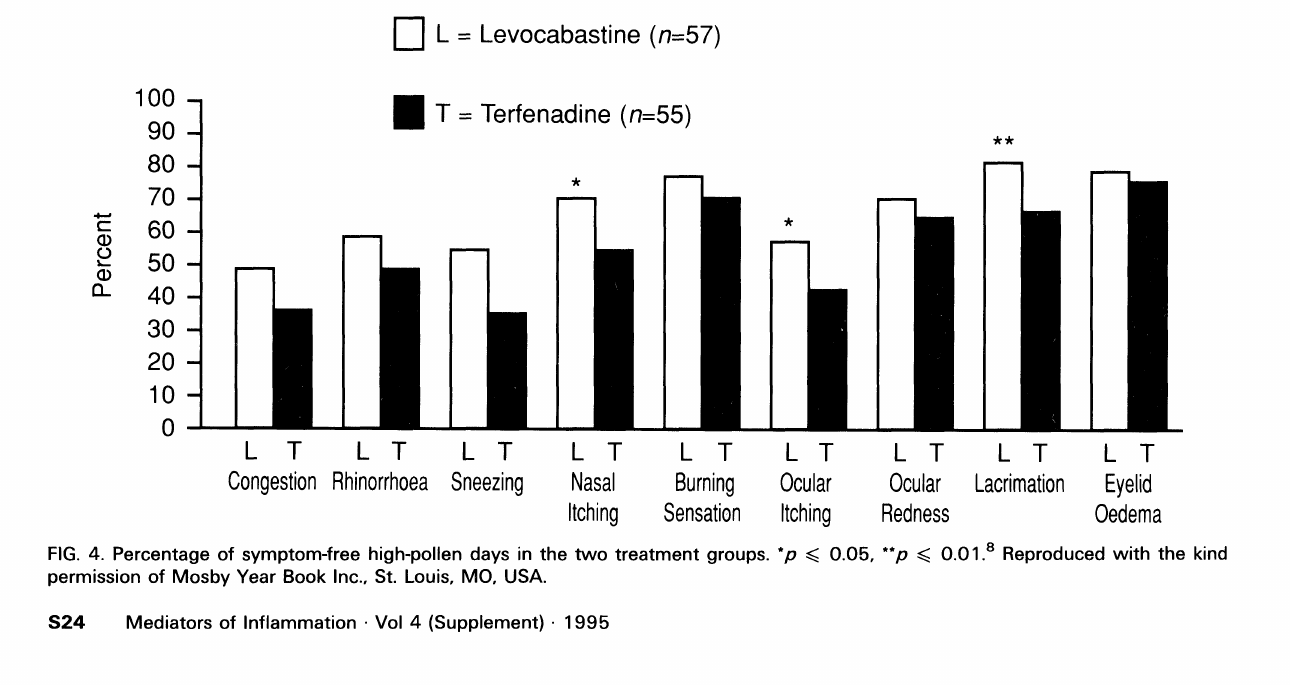
FIG. 4. Percentage of symptom-free high-pollen days in the two treatment groups. *p < 0.05, **p < 0.01.8 Reproduced with the kind permission of Mosby Year Book Inc., St. Louis, MO,